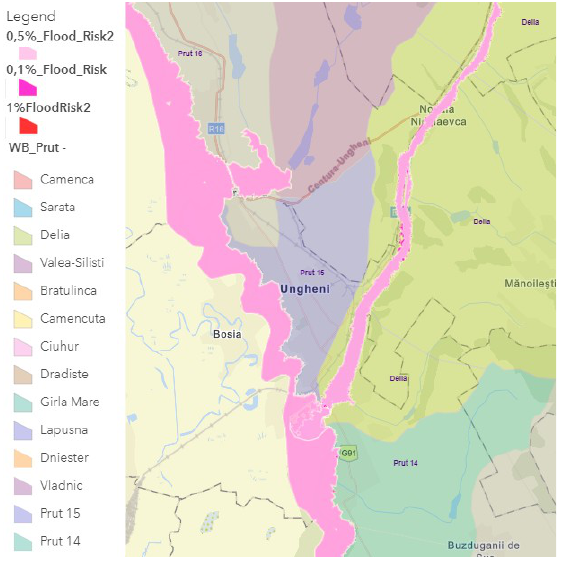
Figure 8. Flood Hazard map and the Water Bodies on Prut